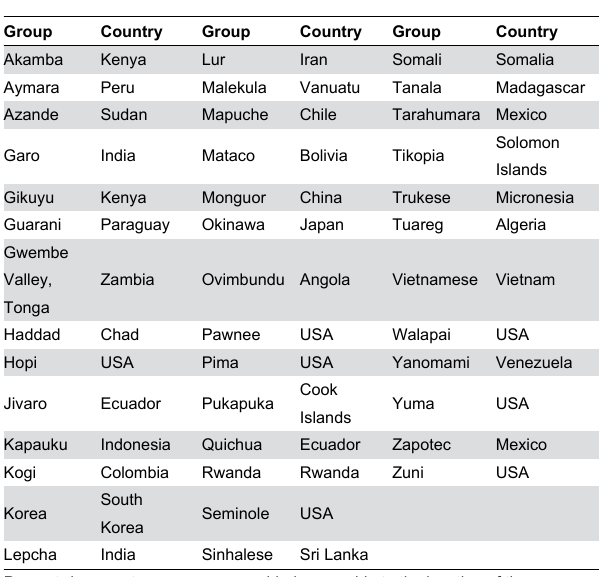
Table 1. Groups in